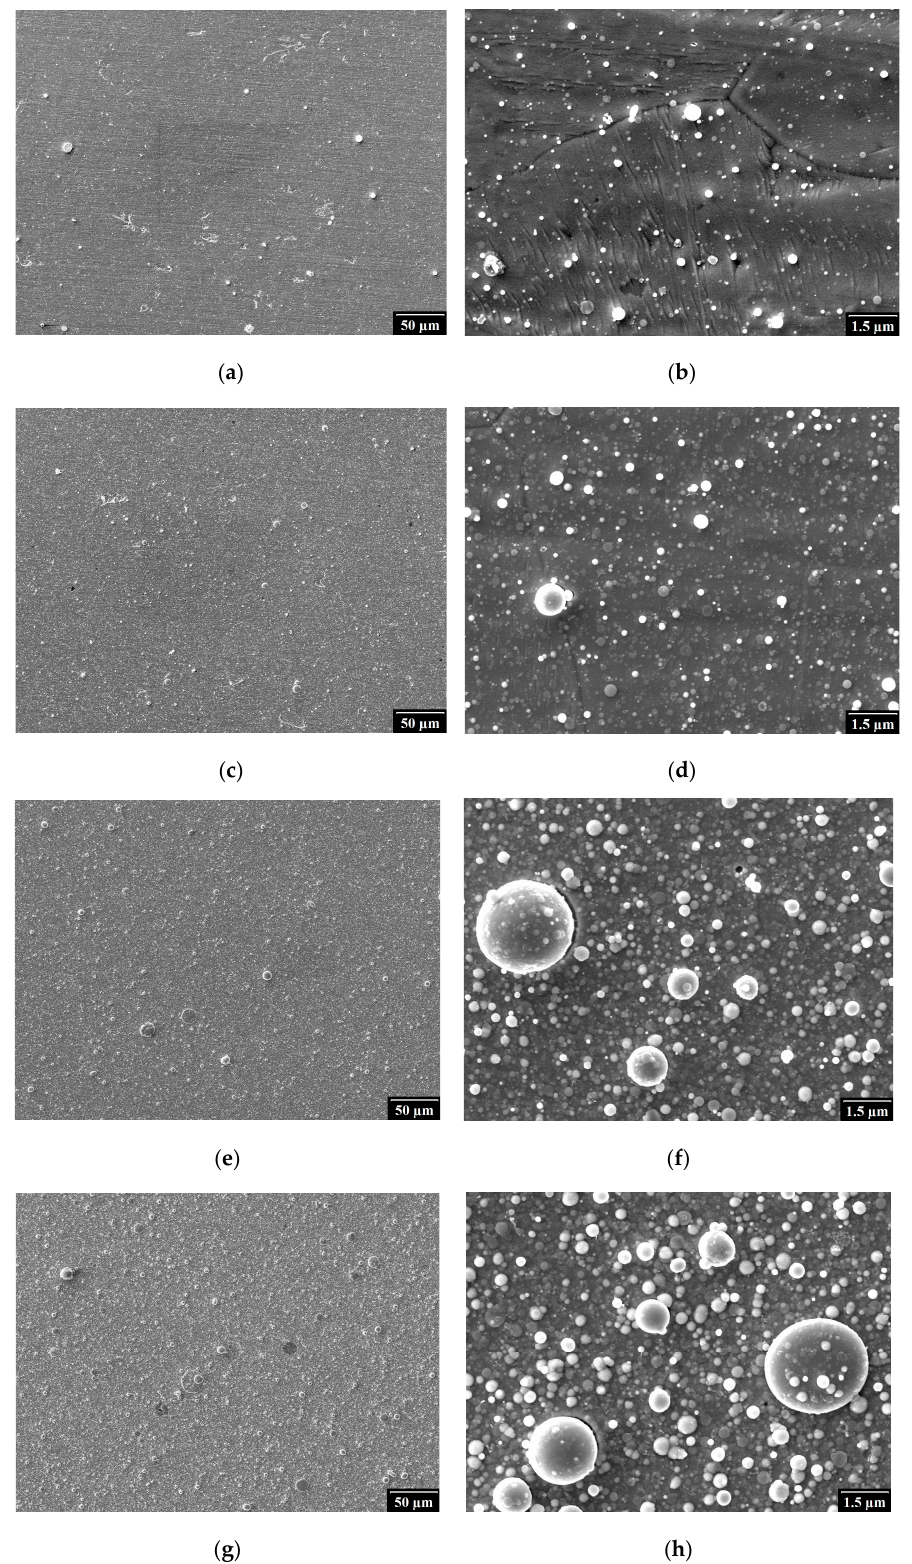
Figure 2. SEM micrographs of samples S16 ( a , b ), S18 ( c , d ), S20 ( e , f ), and S22 ( g , h ); the magnification of images on the left and right side set to 300 × and 10,000 × , respectively; the incident electron beam voltage 100 kV and secondary electrons imaging mode used.